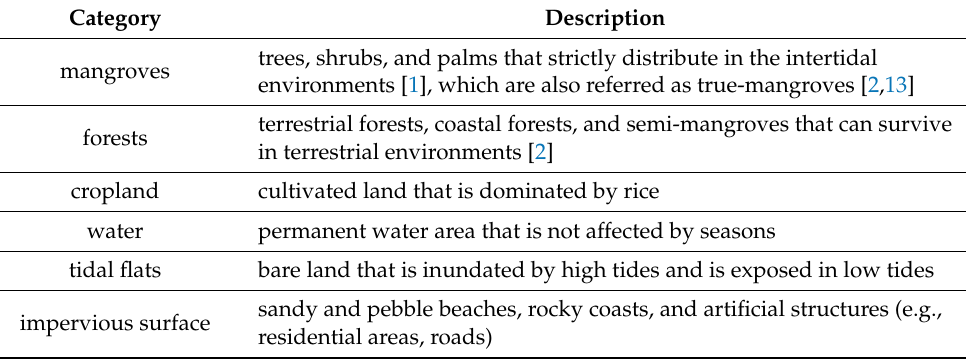
Table 2. The standard classification scheme without consideration of the non-mangrove vegetation near water.